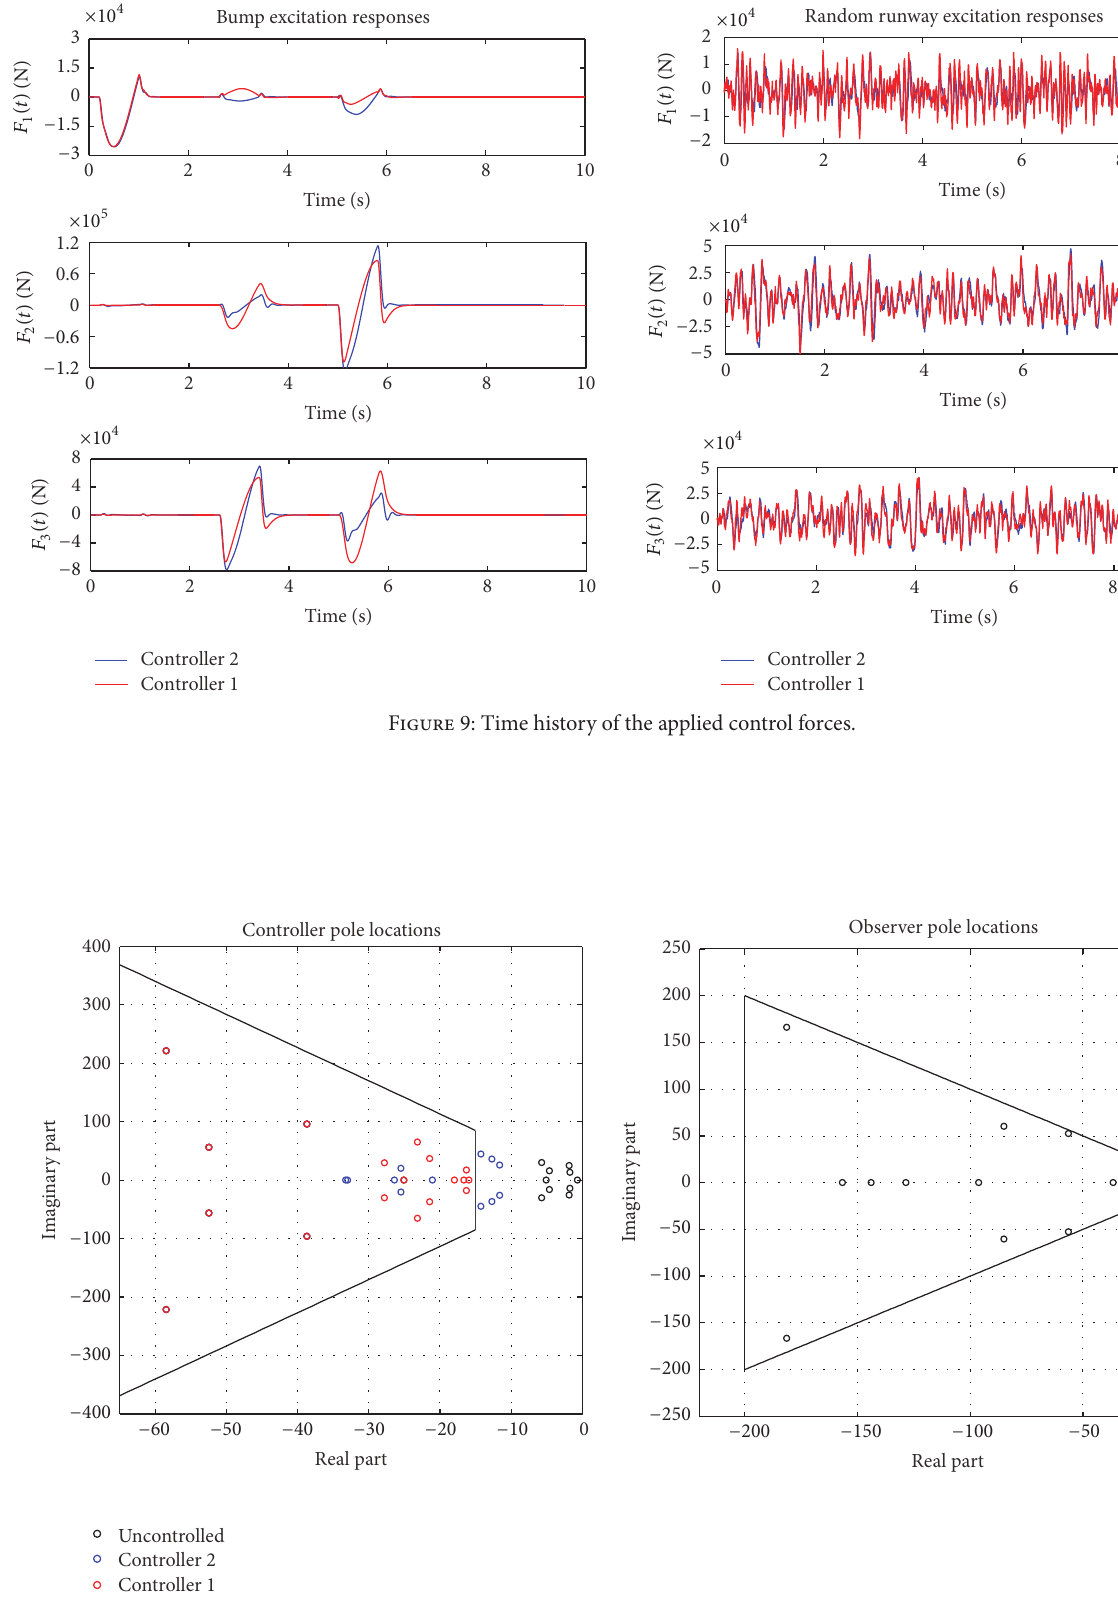
Figure 10: Closed loop and observer pole